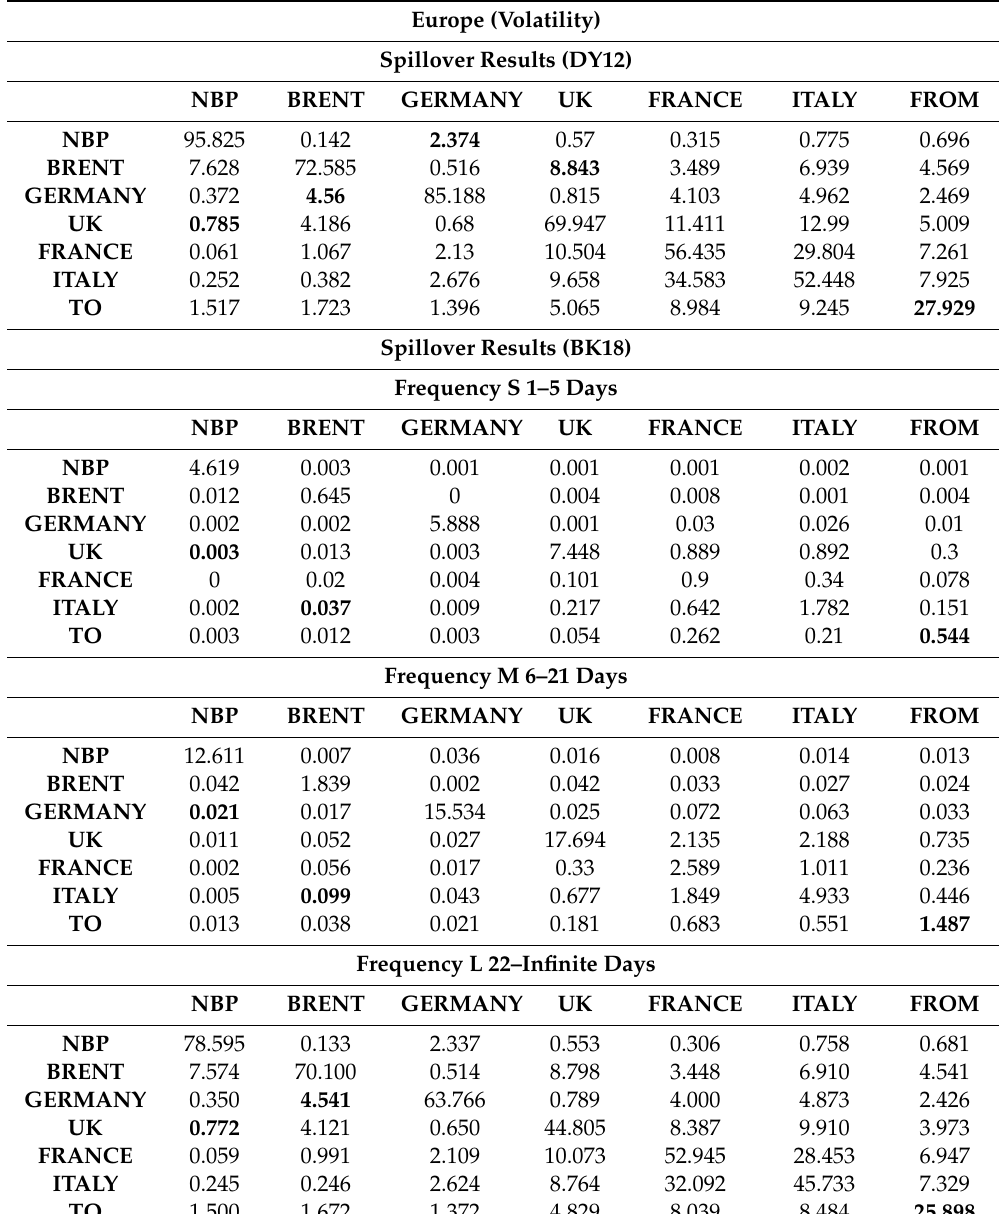
Table 7. Volatility spillover table of) DY12 and BK18